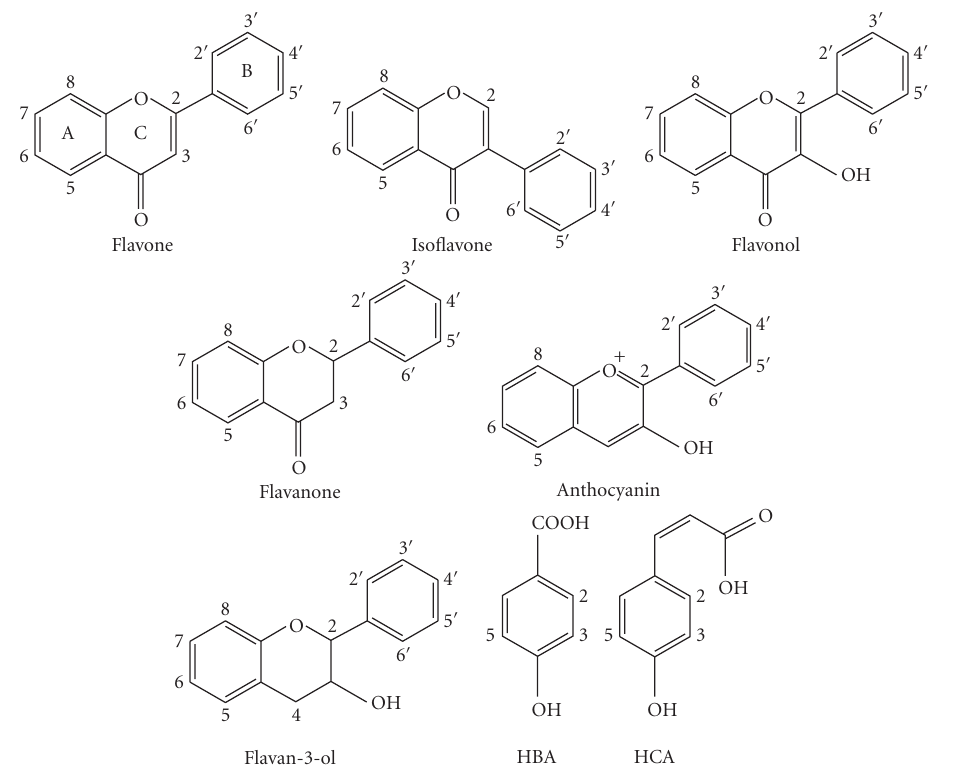
Figure 1: Basic chemical structures of the phenolic compounds used in the present